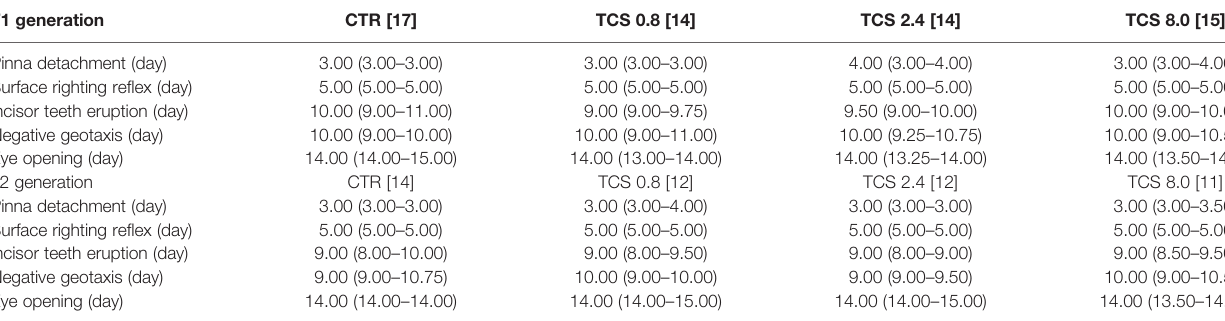
TABLE 6 | Physical and neuromotor development of male pups of F1 and F2